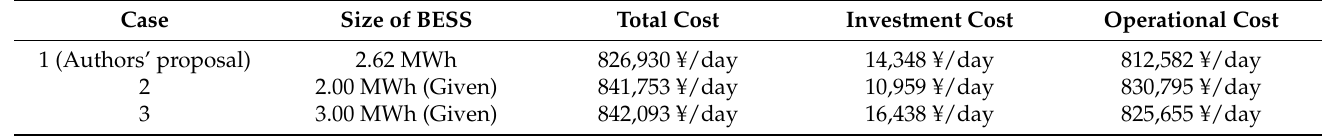
Table 2. Comparison of obtained solutions in Cases